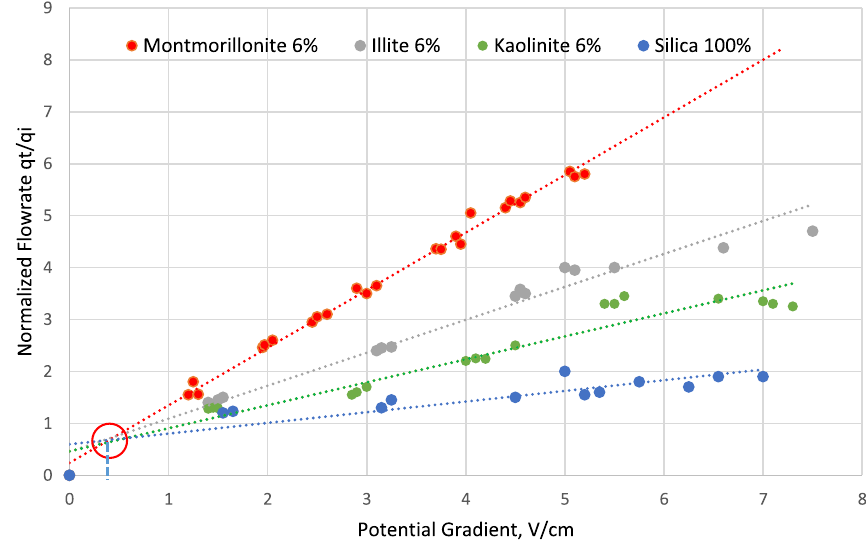
Fig. 7 Potential gradient vs normalized flowrate on clay types (adapted from Chilingar [25]